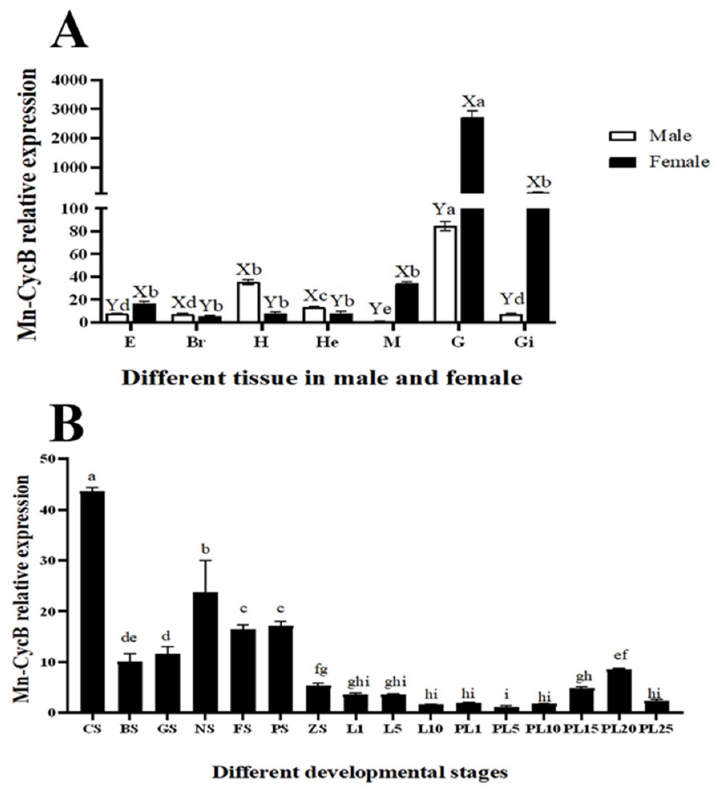
Figure 5. Mn-CycB expression in different mature tissues and developmental stages as determined with qPCR. Lowercase letters on the bars indicate expression differences between different tissue samples (analysis of variance (AVONA)). Capital letters on the bars indicate expression differences in the same tissue between male and female prawns (independent sample t -tests). ( A ) Mn-CycB expression in different mature tissues. ( B ) Mn-CycB expression in different developmental stages. E: eyestalk; Br: brain; H: heart; He: hepatopancreas; M: muscle; G: gonad; Gi: gill; CS: cleavage